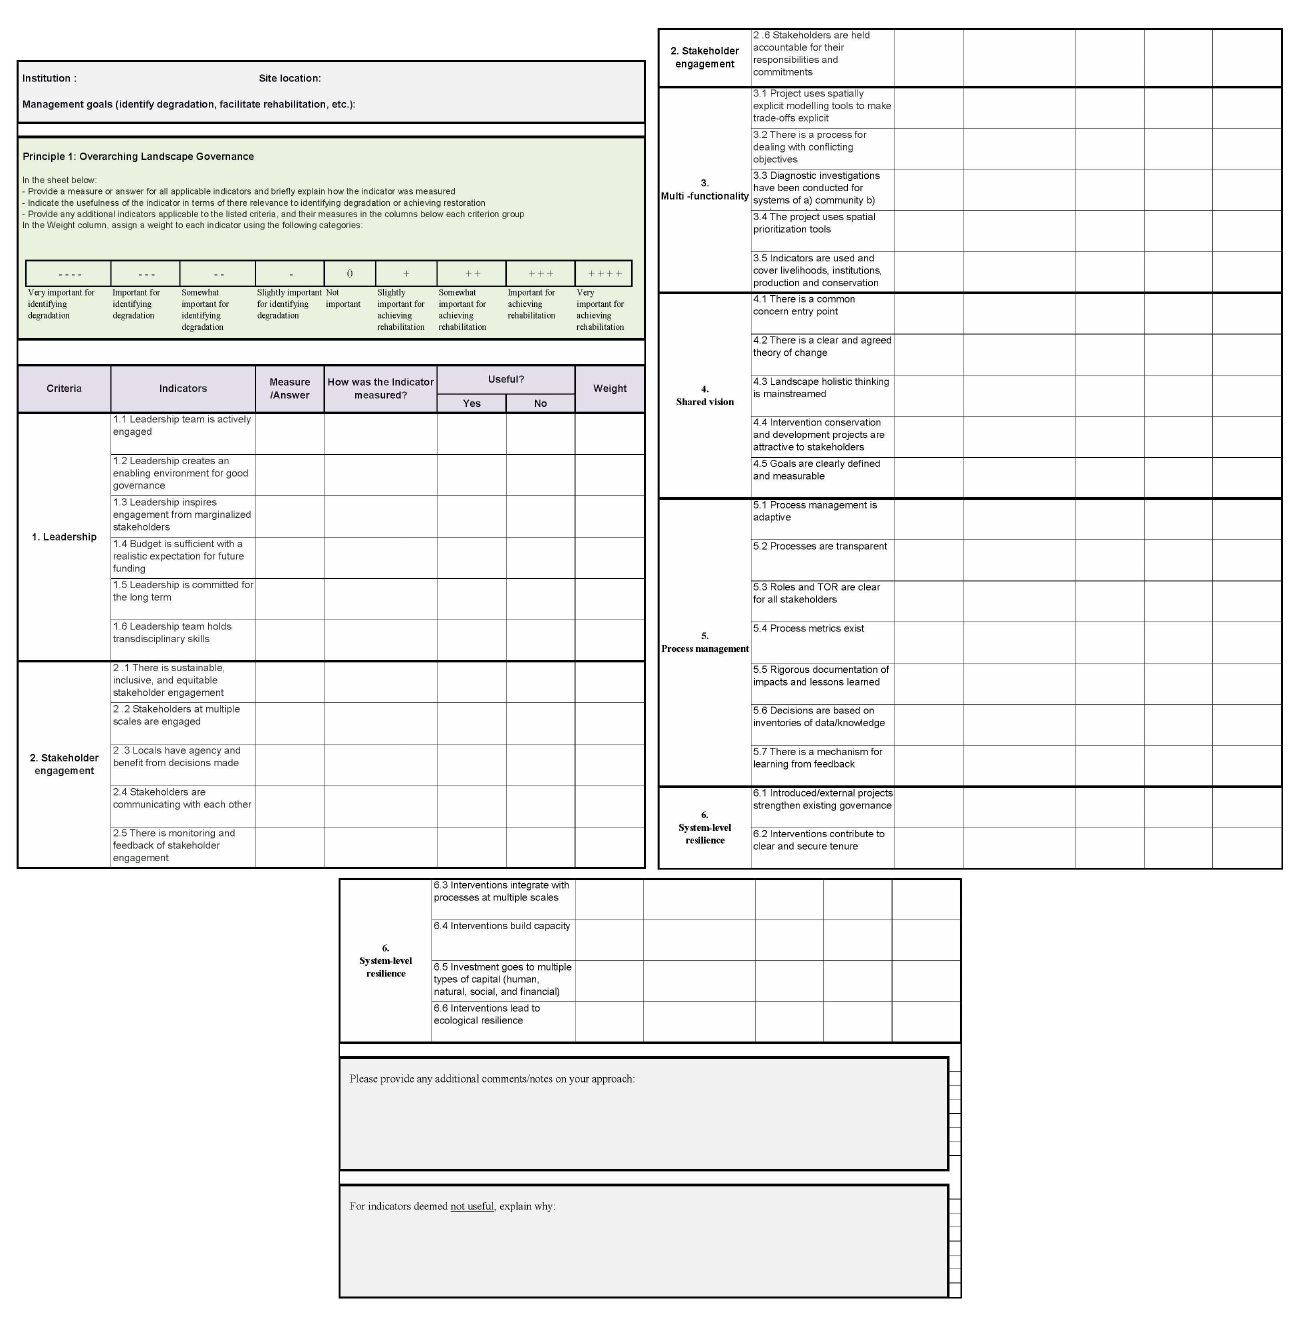
Figure A1. Landscape Governance Table.